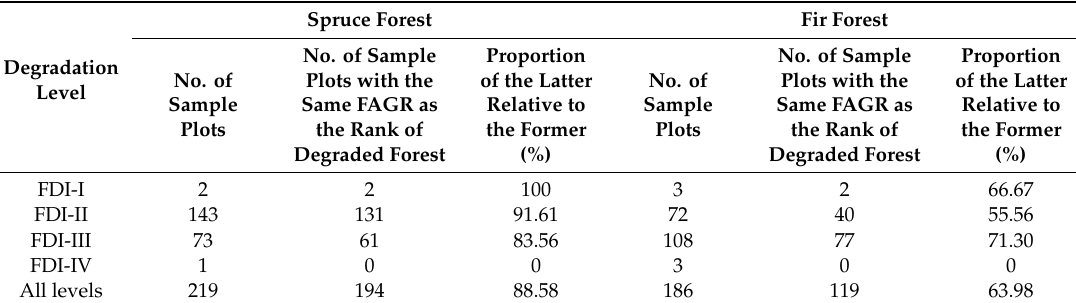
Table 8. Relationship between forest degradation level and Forest accumulation growth rate (FAGR) in the Tibet autonomous region (FDI: forest degradation